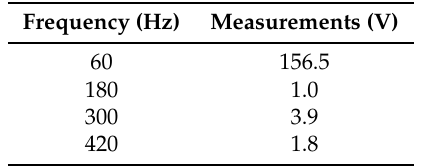
Table 3. Main frequency components of stator input voltage.